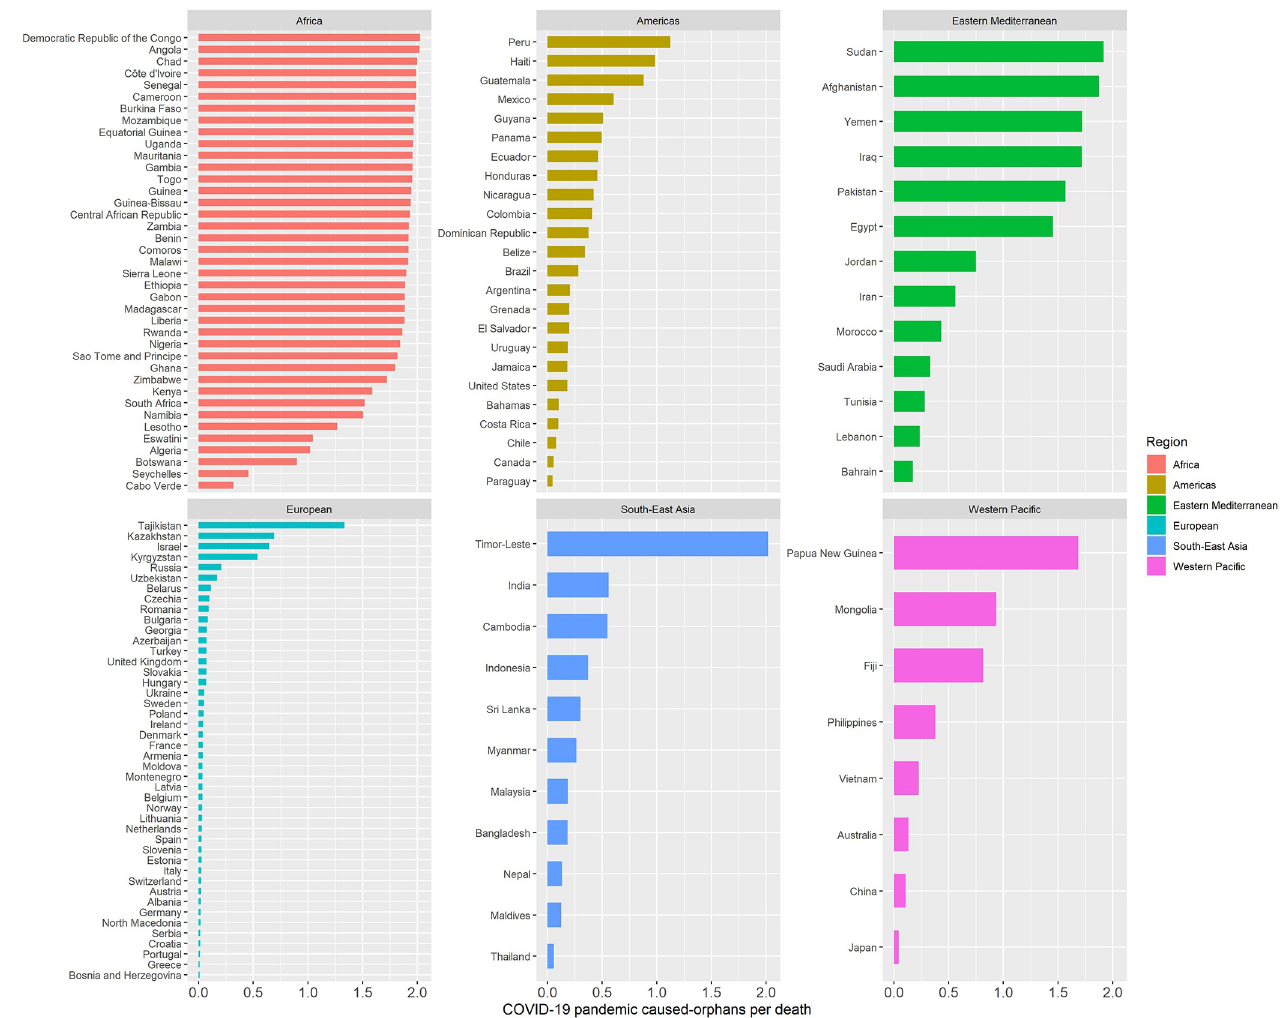
Fig 1. Distribution of orphans per death by country. Countries organized by WHO